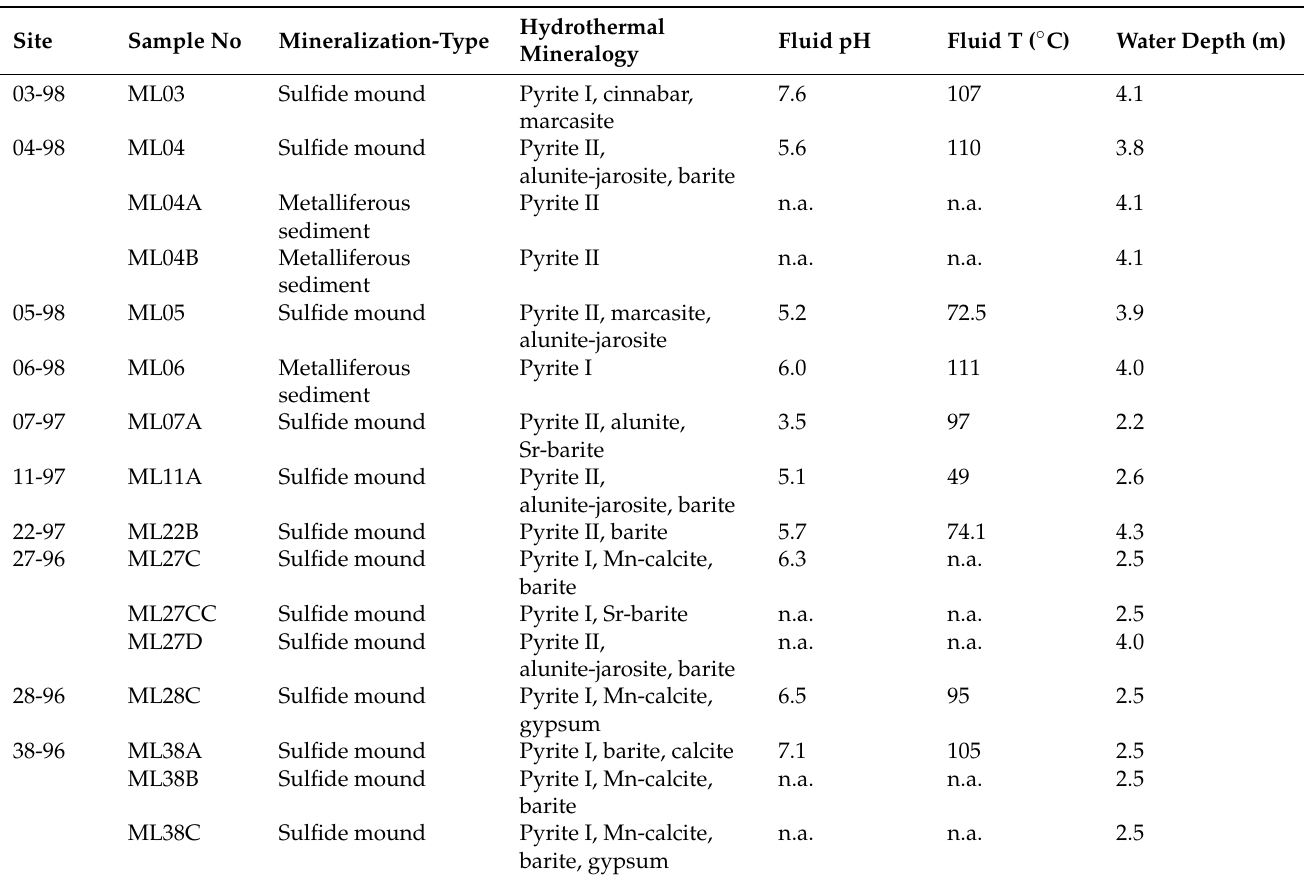
Table 1. Characteristics of hydrothermal precipitates (this study) and fluids at Paleochori Bay. All fluid- and water-depth data are from Valsami-Jones et al. [41] and Wu et al. [44,45].